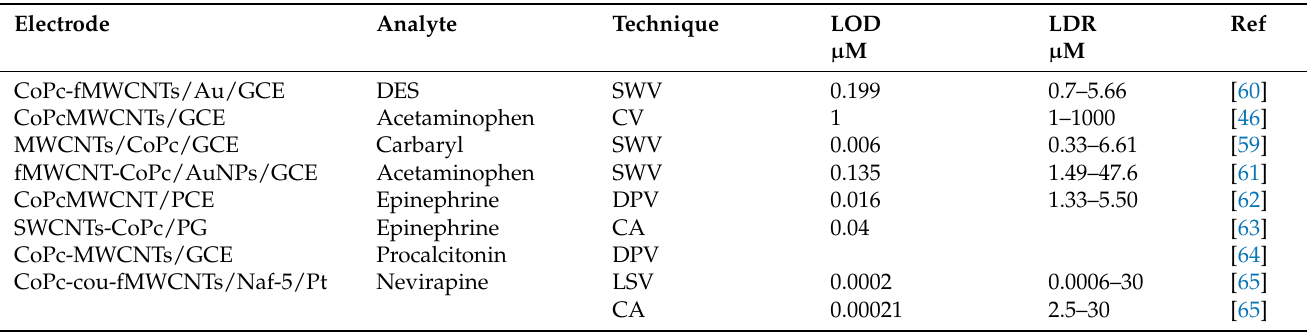
Table 3. Detection of acetaminophen, carbaryl, DES, and epinephrine with CoPc-MWCNT-modified